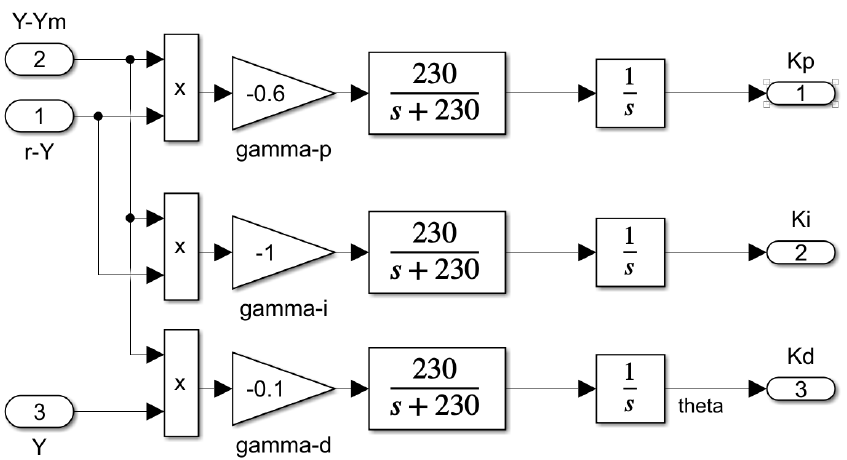
Figure 8. Adjustment mechanism block .